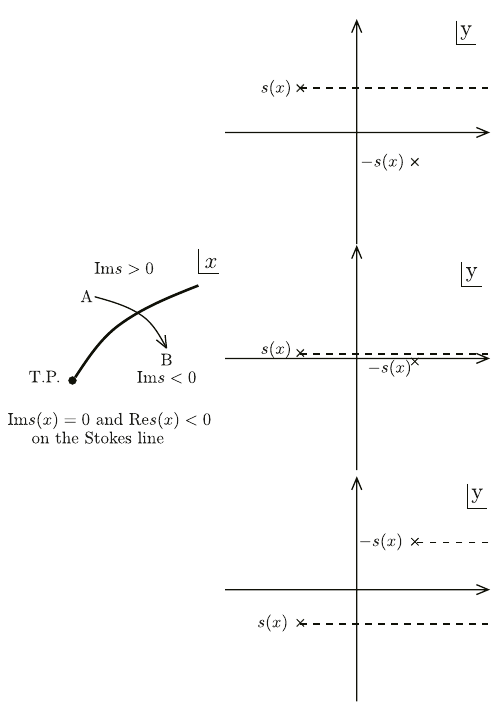
Figure 2 . The Stokes phenomenon is explained by the y -integration. On the left panel, a Stokes line (the other two are omitted) coming out from a turning point is shown. The Stokes line is drawn on the complex x -plane. We take Re [ s ( x )] < 0 for the Stokes line. On the right three panels, the contour of the y -integration in eq. (1.75) is shown. If the solution, whose integration starts from s ( x ) , moves from A to B crossing the Stokes line, the integration contour finally picks up the integration starting from − s ( x )